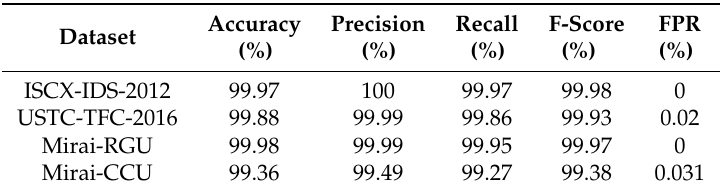
Table 10. Performance evaluation results of the proposed solution on the four datasets with 10-fold